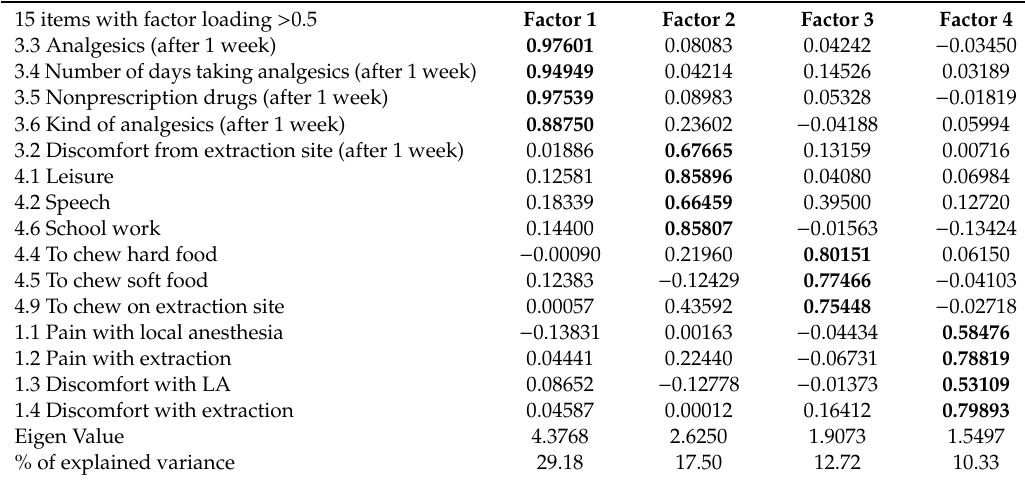
Table 5. The factor structure after Varimax orthogonal